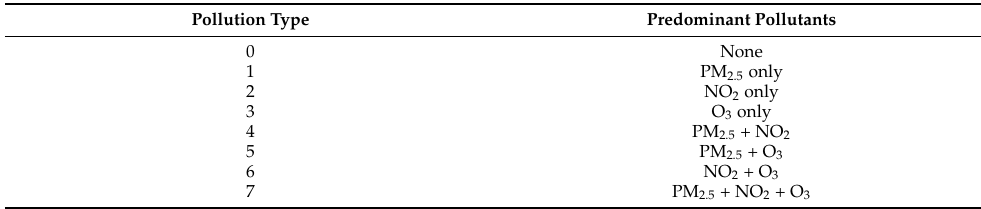
Table 2. The 8 types of pollution and the predominant pollutants (the pollutant whose concentration is higher than the